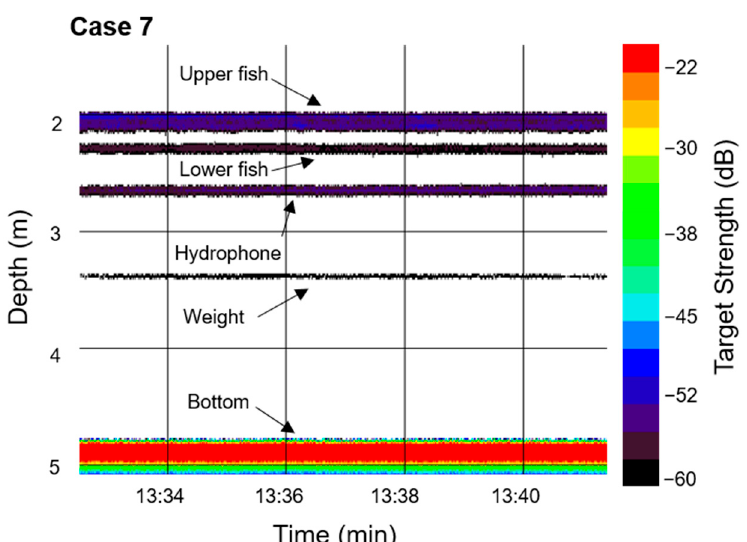
Figure 2. A sample of case 7 experiment of target strength (TS) echogram at 200 kHz from multiple fish. The echo signals from the upper and lower fish were fully separated from the subminiature hydrophone, weight, and bottom.